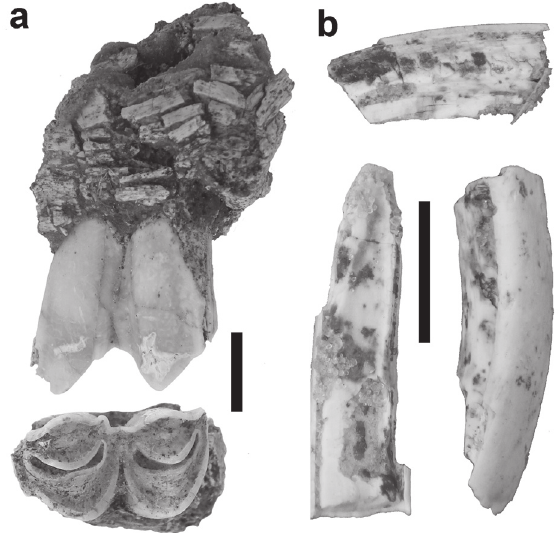
Figure 8 - Fossils from the Cordão Formation. a: upper m2 of Hemiauchenia paradoxa (MCTFM-PV1028) in labial and occlusal views. b: fragmented incisors of rodents (MCTFM- PV1030). Scale bars = 10